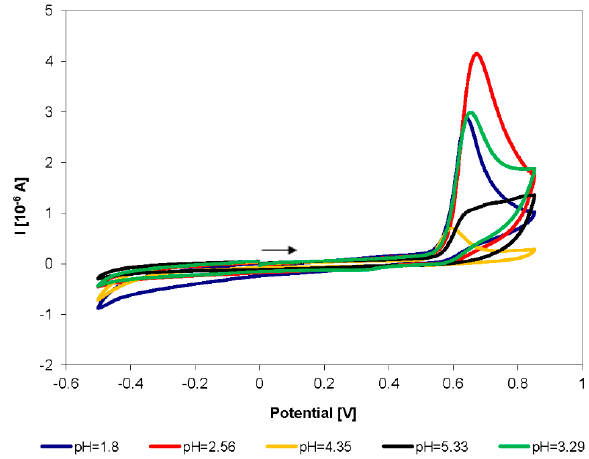
Figure 3. Cyclic voltammograms of 2.7 × 10 − 5 mol·L − 1 itraconazole in B-R buffer in the pH 1.8–11.2 range; v = 100 mV·s − 1 .